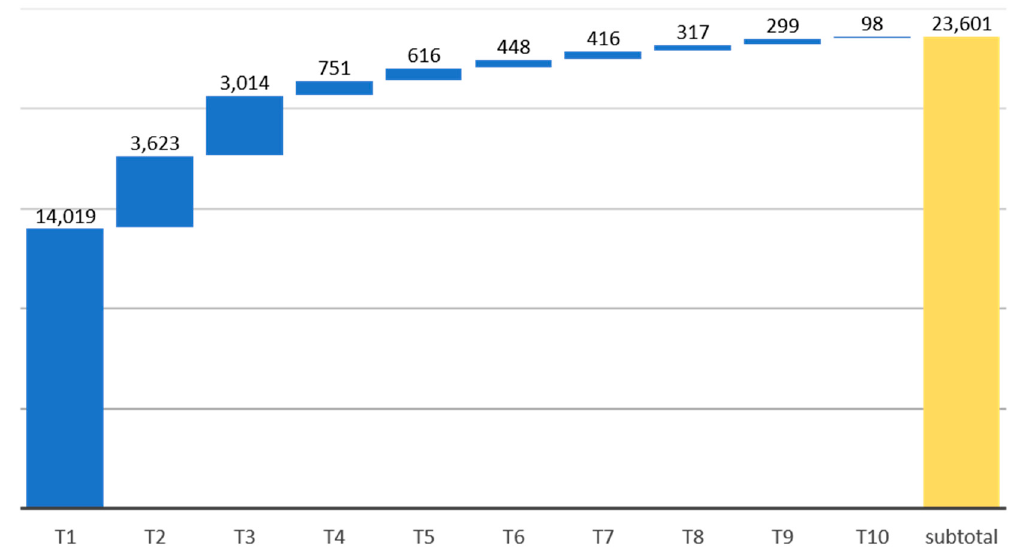
Figure 5. Health benefits of technical pollution control measures (billions of new Taiwan dollars (NTD)).